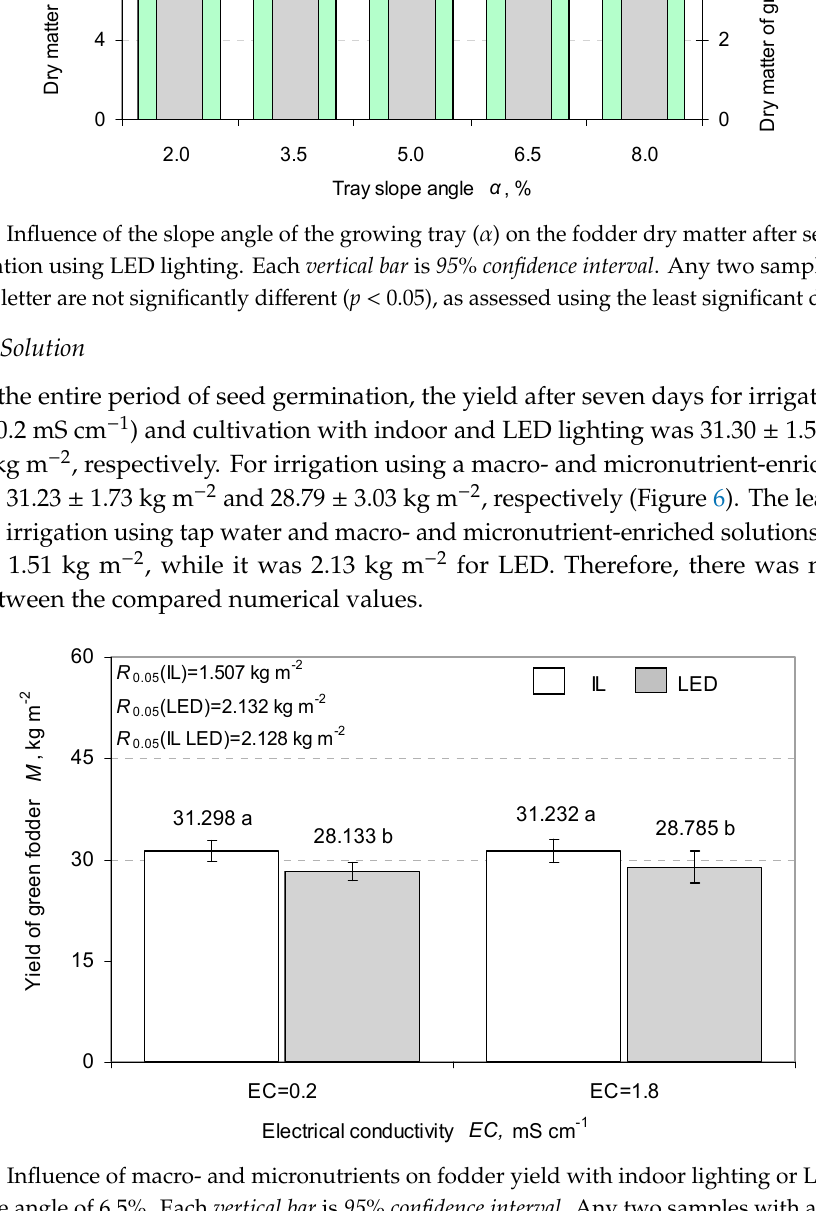
Figure 7. Influence of macro- and micronutrients on the growth of wheat fodder weight with indoor lighting or LED and a growing tray slope angle of 6.5%. Each vertical bar is 95% confidence interval. Any two samples with a common letter are not significantly different ( p < 0.05), as assessed using the least significant difference. Analysis of the weight gain (measured twice daily) showed that the influence of macro- and micronutrients in the nutrient solution on the yield of wheat fodder started to develop only after 132 h of cultivation, i.e., from the sixth day (Figures 8 and 9). This could be because of decreasing fat and starch reserves, which are critical in providing energy for the germination process.